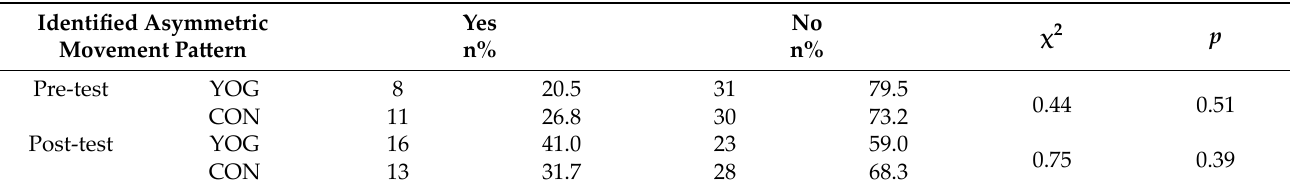
Table 5. FMS asymmetric movement patterns at pre‑ and